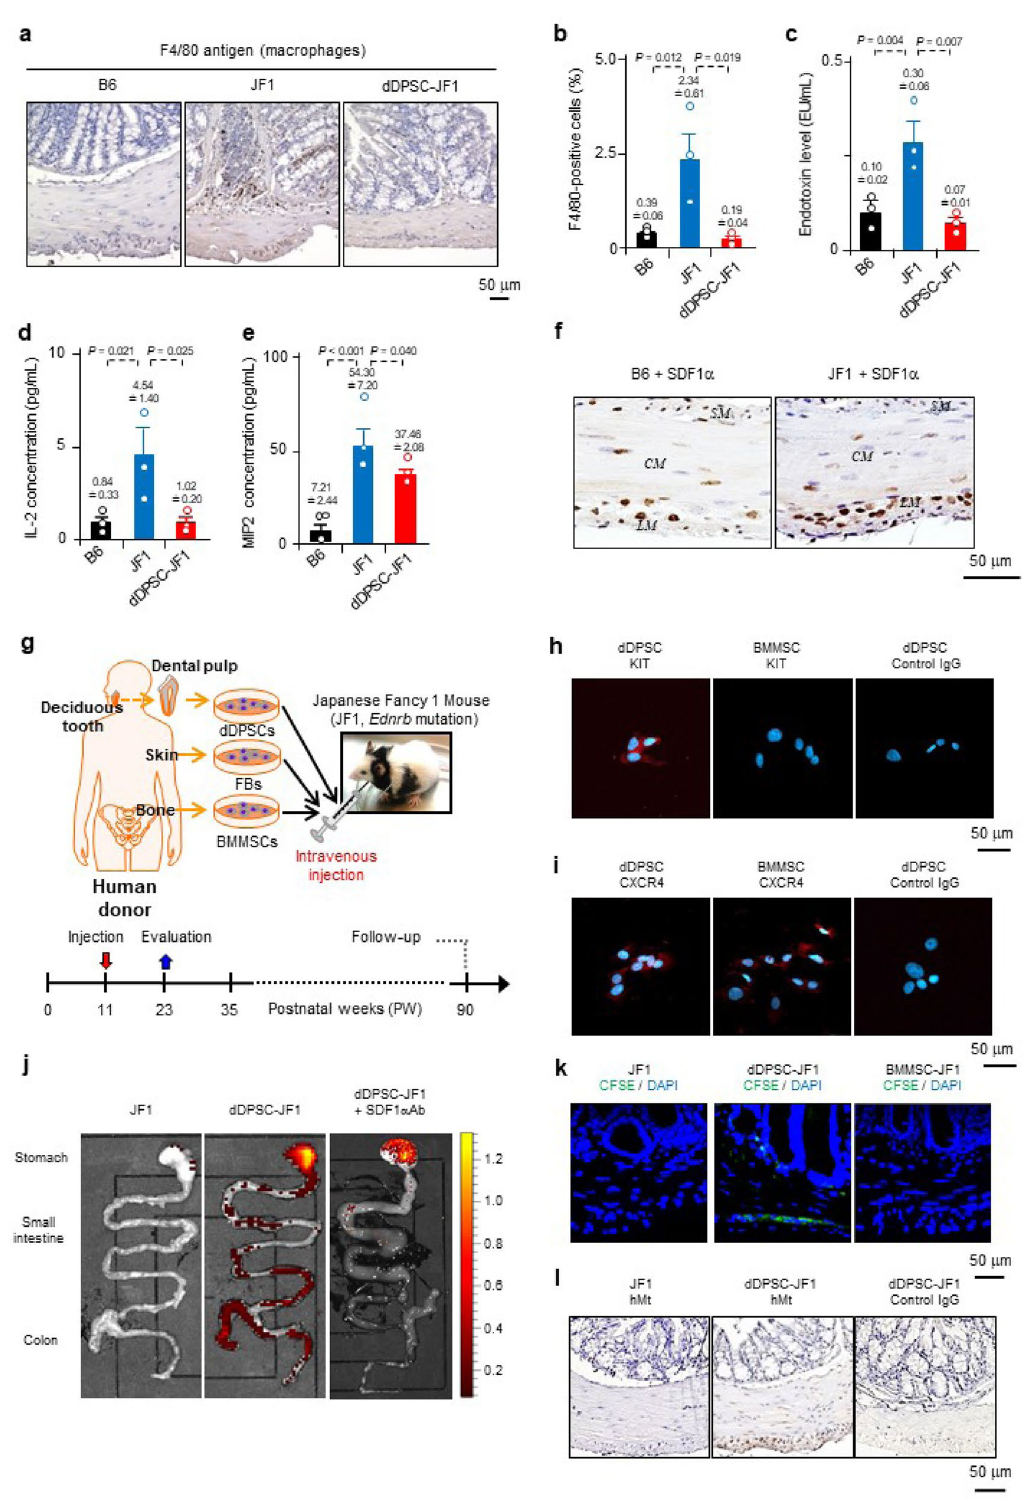
Figure 1. Intestinal migration of dDPSCs. (a) Macrophages in the proximal colon. ( b ) Macrophage percentage in the proximal colon (mean ± SEM, n = 3). ( c–e ) Intestinal endotoxin, IL-2 and MIP2 levels (mean ± SEM, n = 3). ( f ) Proximal colon SDF1α expression (× 200). CM: circular muscle; LM: longitudinal muscle; SM: submucosal layer. ( g ) Experimental schedule. ( h , i ) Stem cell KIT and CXCR4 expression. j , Mouse intestine (ex vivo fluorescence imaging; n = 1). ( k ) CFSE-labelled cells 3 days post-transplantation (proximal colon, × 200). Representative of ≥ 3 experiments. ( l ) hMt-containing cells 12 weeks post-transplantation (proximal colon, × 200). ( a,f,h,i,k,l ) Representative of ≥ 2 independent